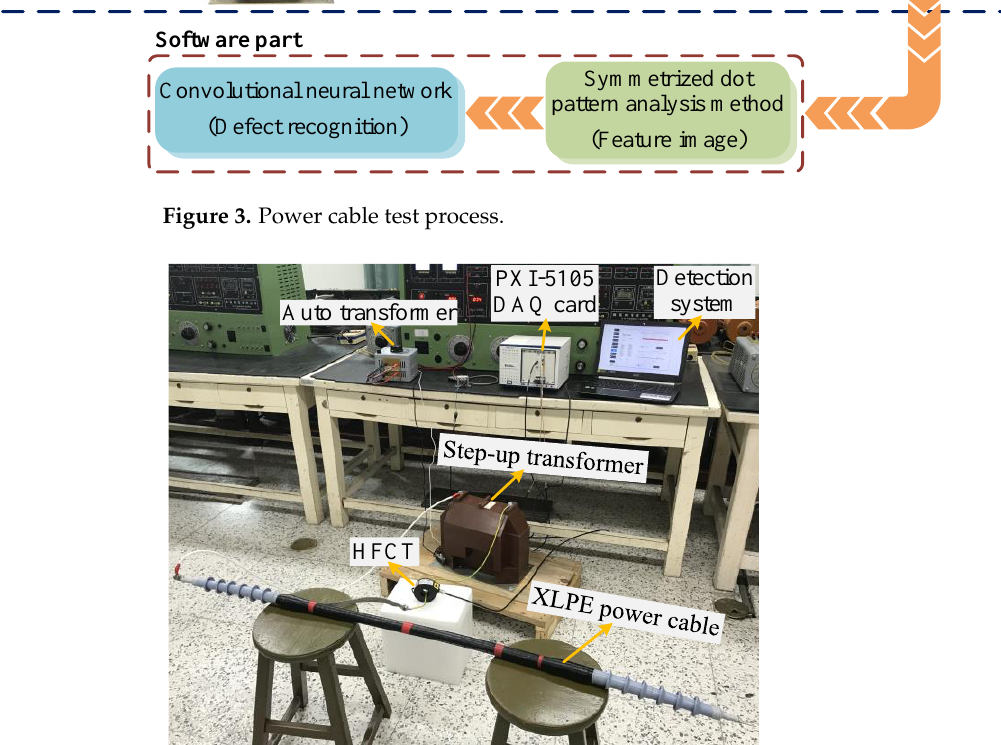
Figure 4. Power cable testing platform.